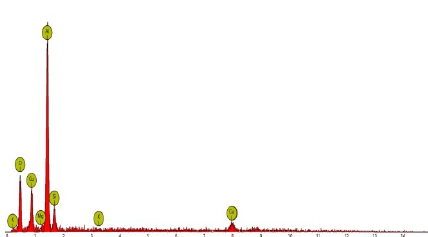
Figure 14: XRD results of the generated wear debris under fixed nor- mal load ( F N ) 40 kN and at linear sliding velocity ( S V ) of 6.35 cm/s